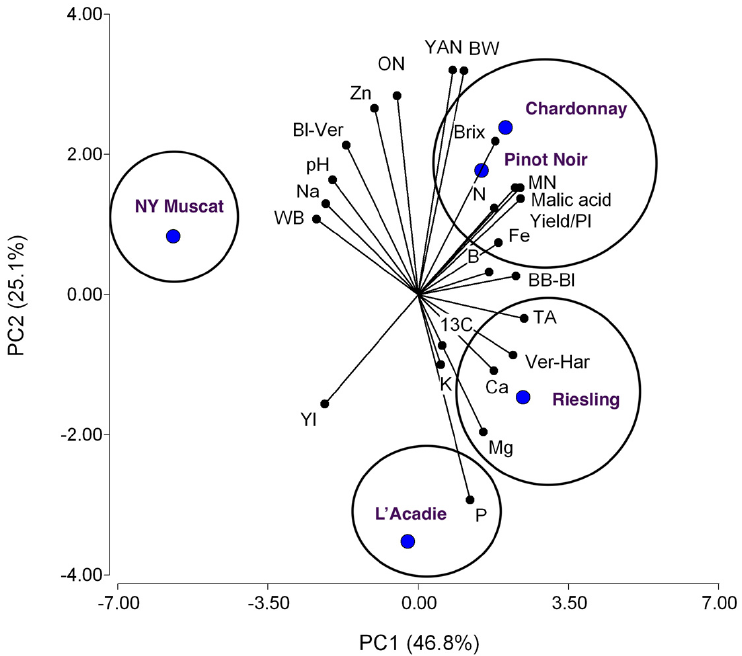
Figure 2. Principal component analysis (PCA) performed with the variables obtained from cold-hardy interspecific hybrid grapes (L’Acadie and New York Muscat) and Vitis vinifera varieties (Chardonnay, Riesling, and Pinot Noir) in 2017–2019 seasons. NY: New York. The distribution of variables (black lines) and individual observations according to varieties (blue dots) on PC 1 and PC 2 are shown. Yield/pl: yield per plant; Yl: stem water potential; WB: weight of 200 berries; BW: bunch weight; YAN: yeast assimilable nitrogen; MN: mineral nitrogen; ON: organic nitrogen; TA: total